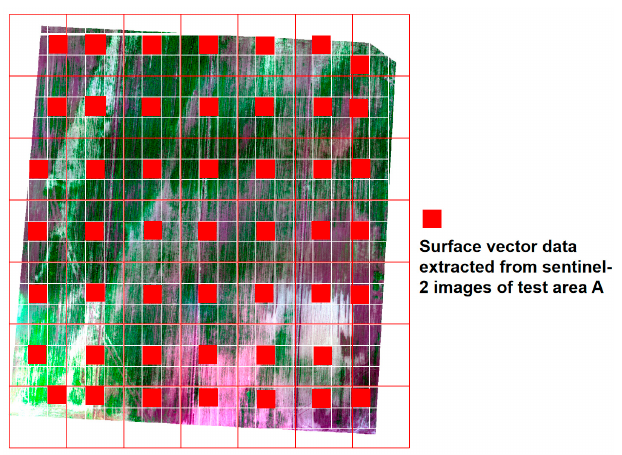
Figure 3. Distribution map of the extracted surface vector data of test area A.